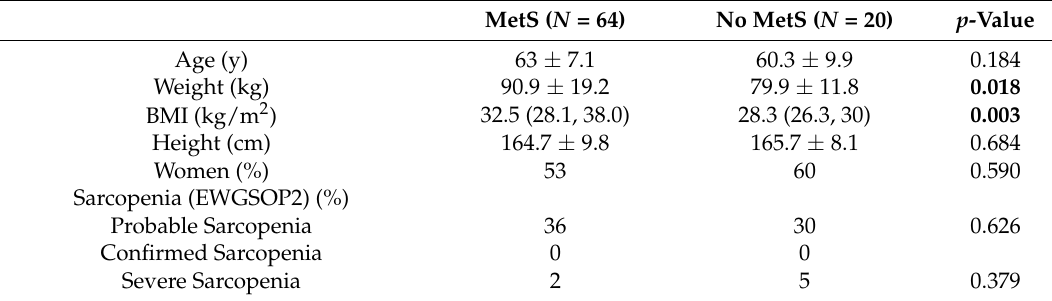
Table 1. Descriptive characteristics for individuals with and without metabolic